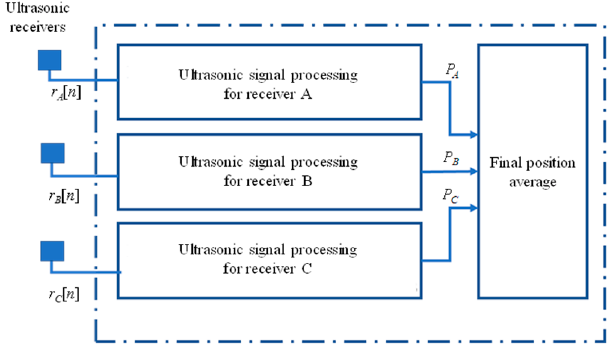
Figure 4. General block diagram of the processing proposed for the multiple receiver prototype.